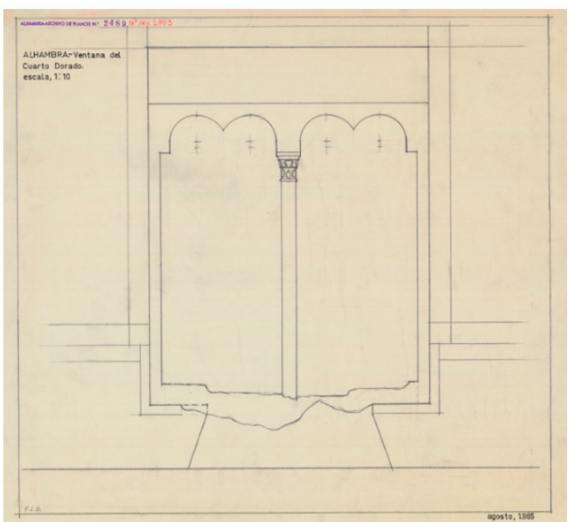
Figure 24. Mullioned window in the Cuarto Dorado showing interior damage. Elevation by Fernando L ó pez D í az de la Guardia in August 1965. © Archivo del Patronato de la Alhambra y Generalife, Photograph Collection, P-002703.